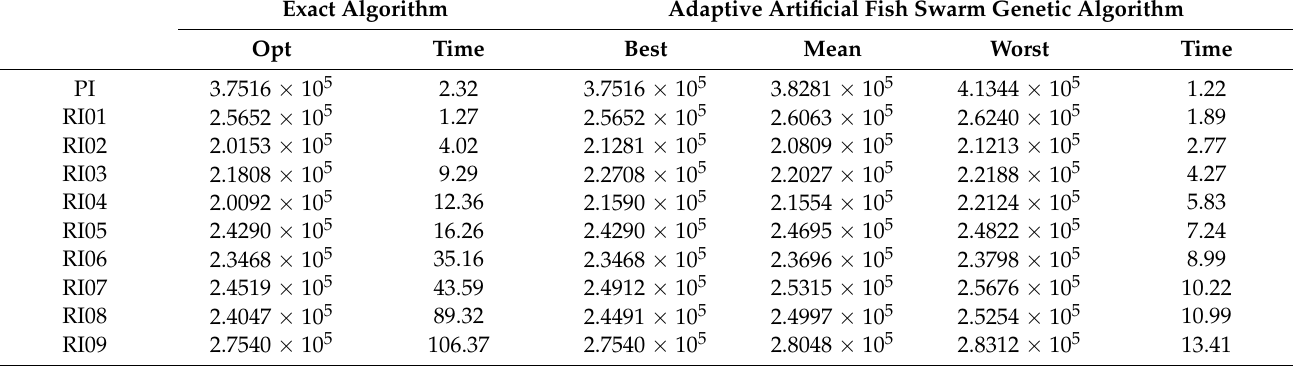
Table 10. Two algorithms for solving two kinds of instances. Exact Algorithm Adaptive Artificial Fish Swarm Genetic